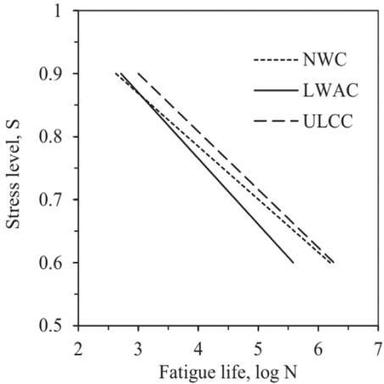
The comparison of S-N curves for ULCC, LWAC, and NWC, adapted from.